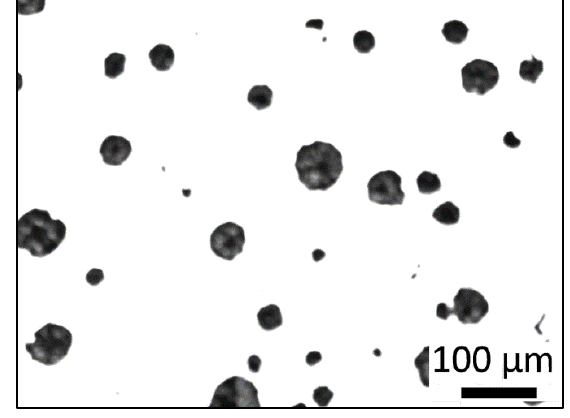
Figure 4. Optical micrograph of the SGI-3 specimen; thickness: 75 mm.